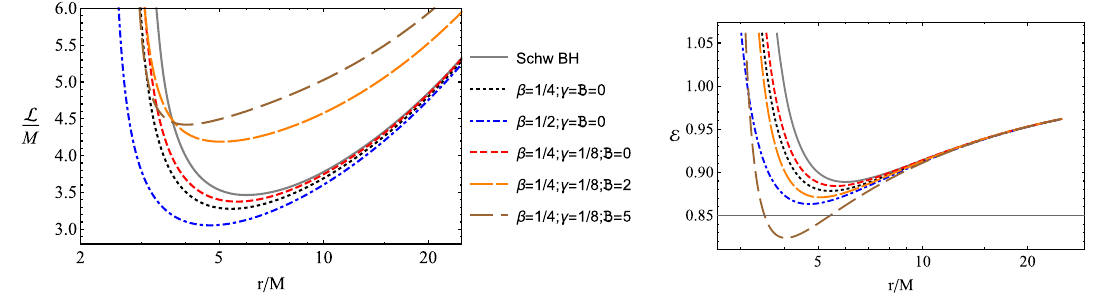
Fig. 9 Radial dependence of specific angular momentum (at left) and energy (at right) correspond to the circular orbits of the magnetized particles around magnetically charged BHs in EMS theory for different values of the parameters β,γ and B Fig. 10 ISCO radii as a function of the magnetic charge of the EMS BH for the different values of parameters β,γ and